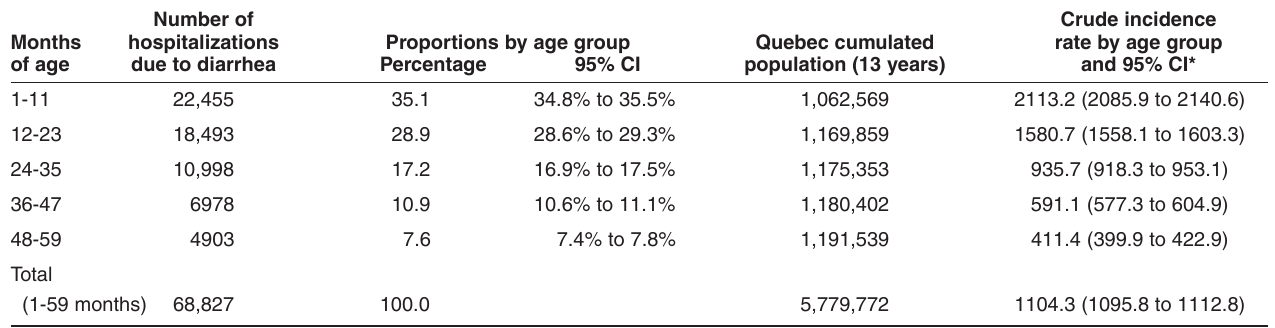
TABLE 3 Numbers and crude incidence rates, by age group, of diarrhea-related hospitalizations (all diagnoses) among children younger than five years of age in Quebec, April 1, 1985 to March 31, 1998